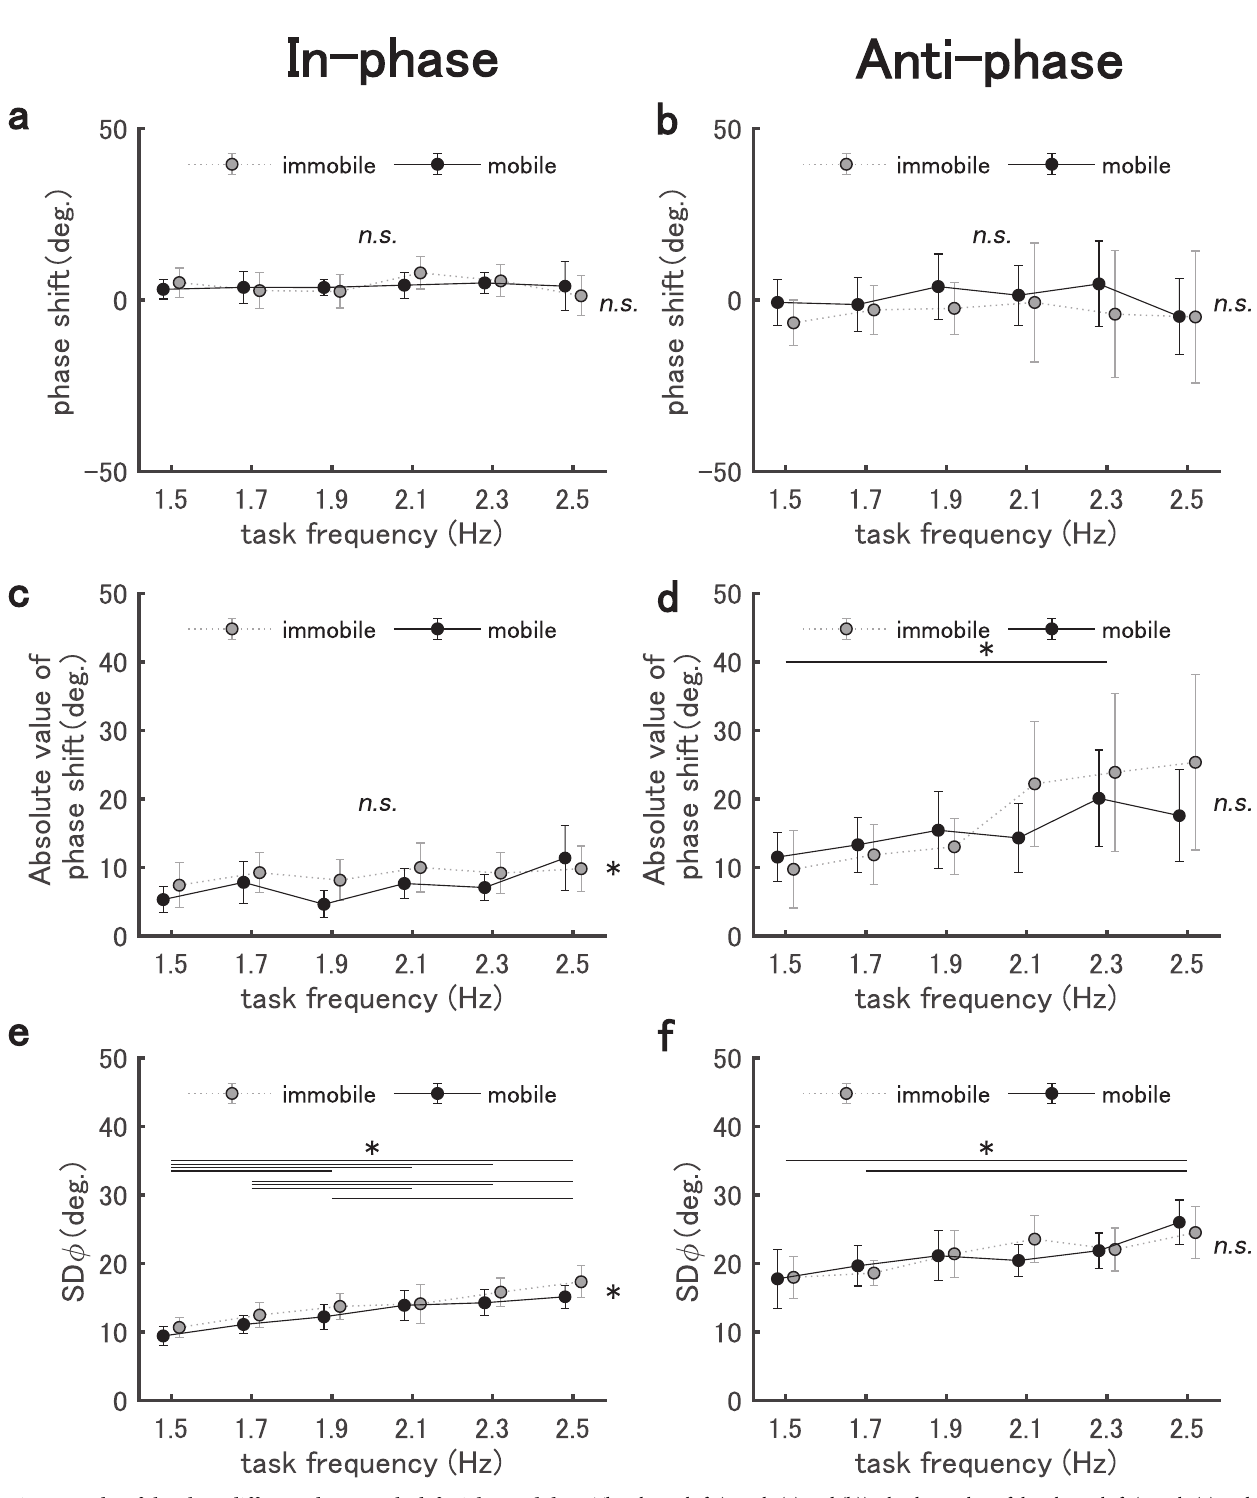
Fig 8. Results of the phase difference between the left-right pendulum. The phase shift (panels (a) and (b)), absolute value of the phase shift (panels (c) and (d)), and SD ϕ (Fig 8e and 8f) are shown for each phase mode (in-phase and anti-phase). Line plots with markers indicate the mean values for 18 participants, and error bars indicate 95% confidence intervals. Asterisks represent pairs that were significant in the Watson-Williams test (performed as a post-hoc test when the two-factor Harrison-Kanji test was significant).